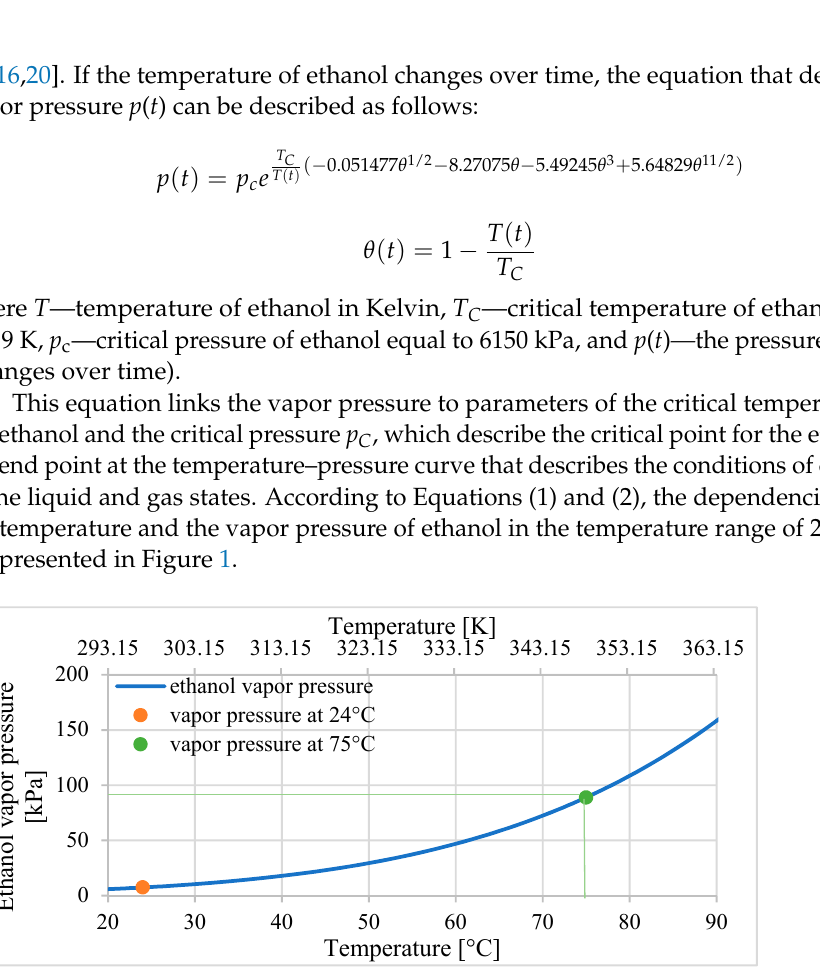
Figure 1. Vapor pressure of ethanol calculated using Equations (1) and (2).